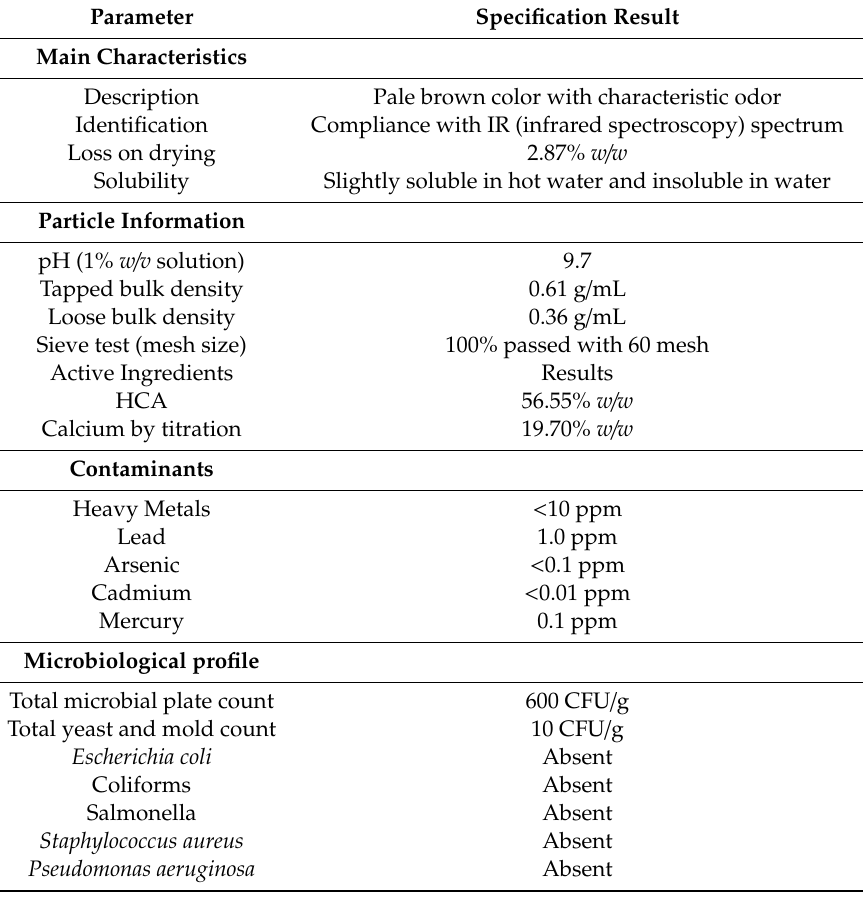
Table 1. Specification of the Garcinia cambogia Extract